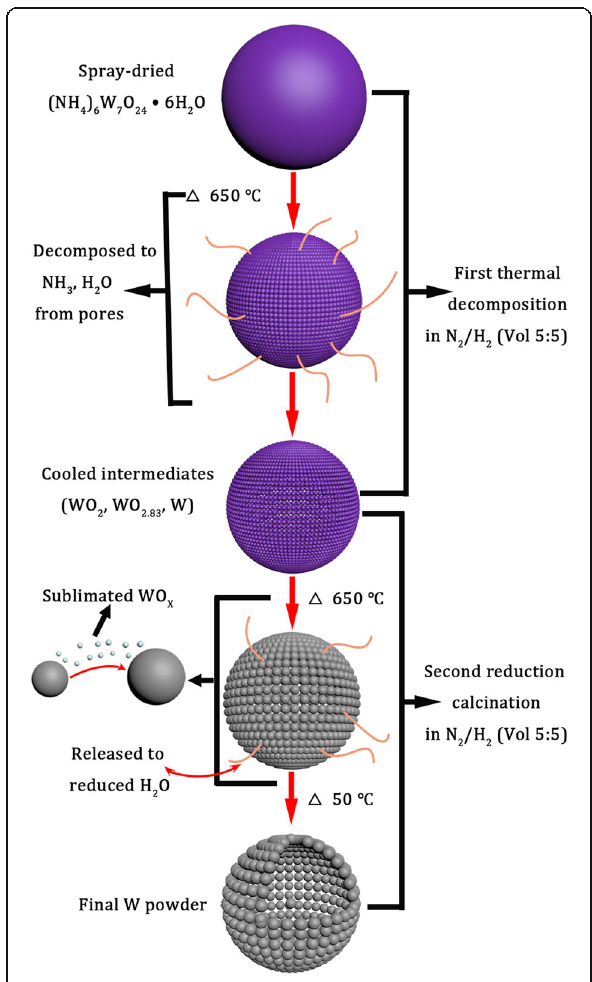
Fig. 8 The microstructural transformation mechanisms of spray dried (NH